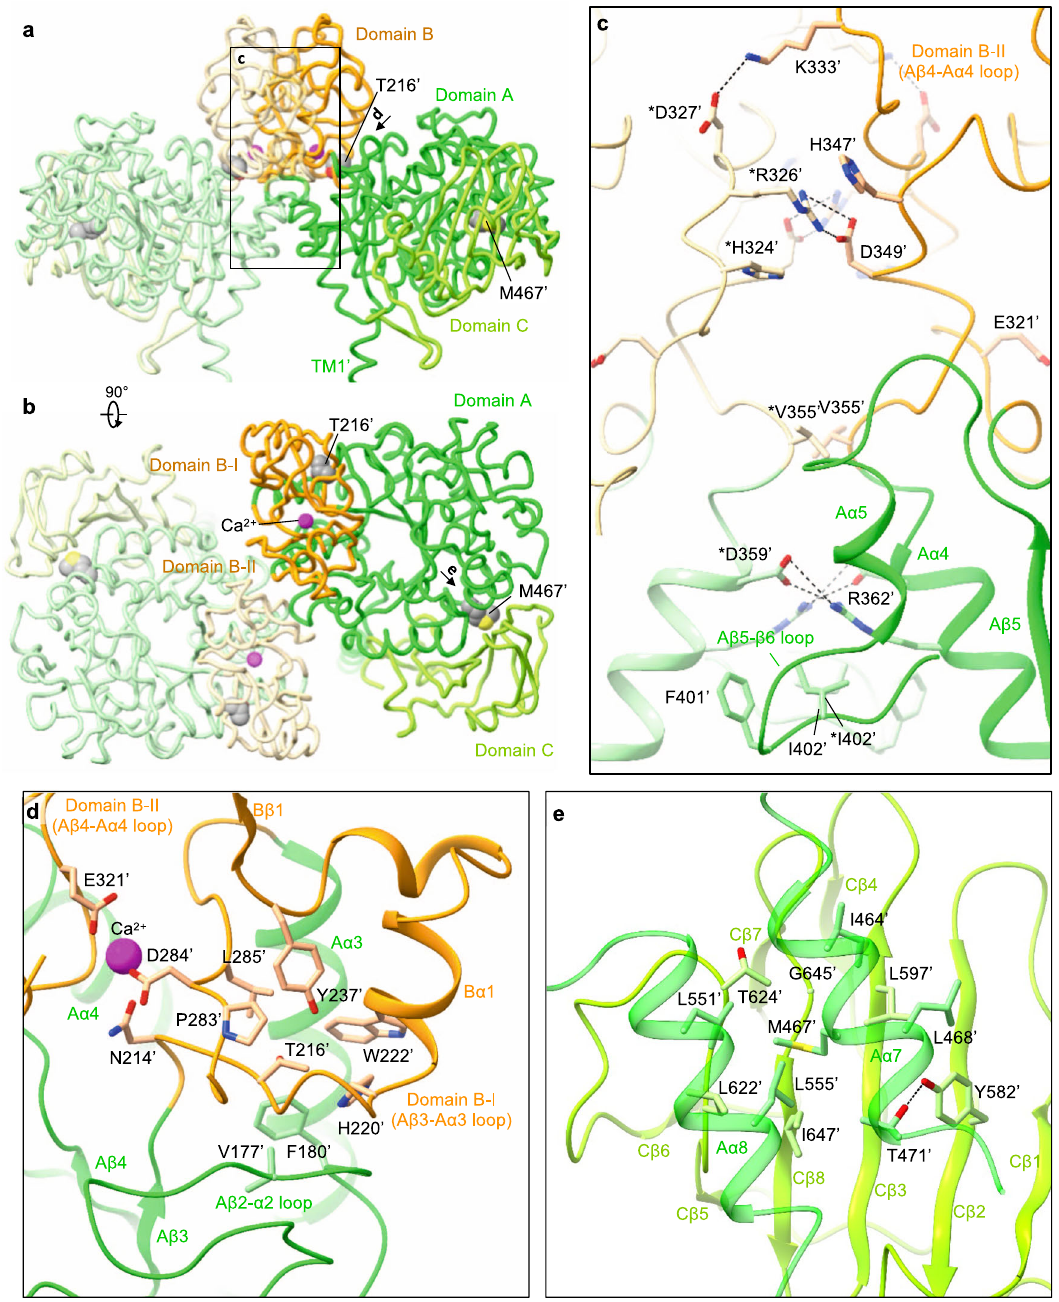
Fig. 4 The rBAT ectodomain. a Structure of the ectodomain homo-dimer. The three subdomains are A (green), B (orange) and C (light green). Common cystinuria-related residues Thr216 ′ and Met467 ′ and the Ca 2 + ions are shown as spheres. b Extracellular view of the rBAT ectodomain. c Zoom-up of super-dimer interface. Salt bridges, π -cation- π stacking and van-der-Waals interactions are indicated. Residues from the adjacent protomer are marked with asterisks (*). d Interaction network around Thr216 ′ and Ca 2 + . e Interaction network around Met467 ′